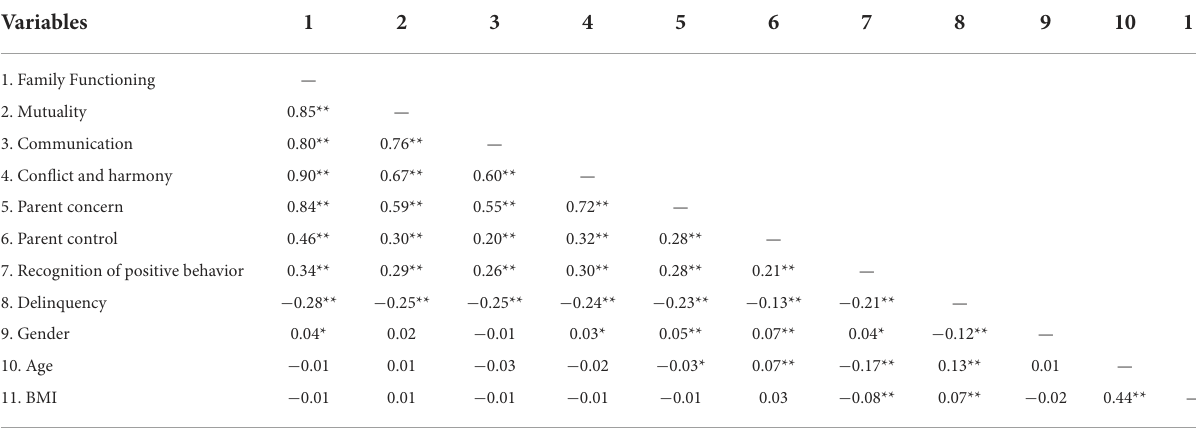
TABLE 3 Intercorrelation matrix for family functioning variables, positive behavior recognition, and delinquency.